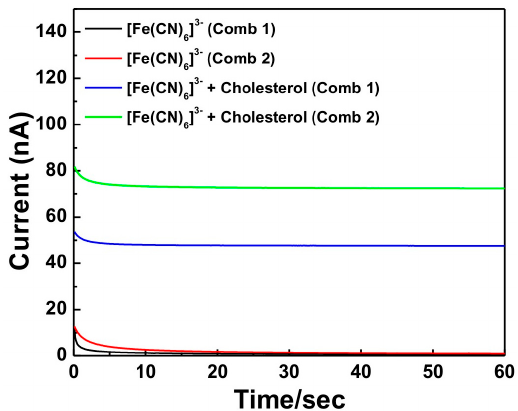
Figure 5. Chronoamperograms from both combs of AuNP/carbon IDEs in 0.3 mM cholesterol in 50 mM phosphate-buffered saline (PBS) containing 10 mM [Fe(CN) 6 ] 3 − (applied potential = 0.6 V vs. Ag/AgCl).